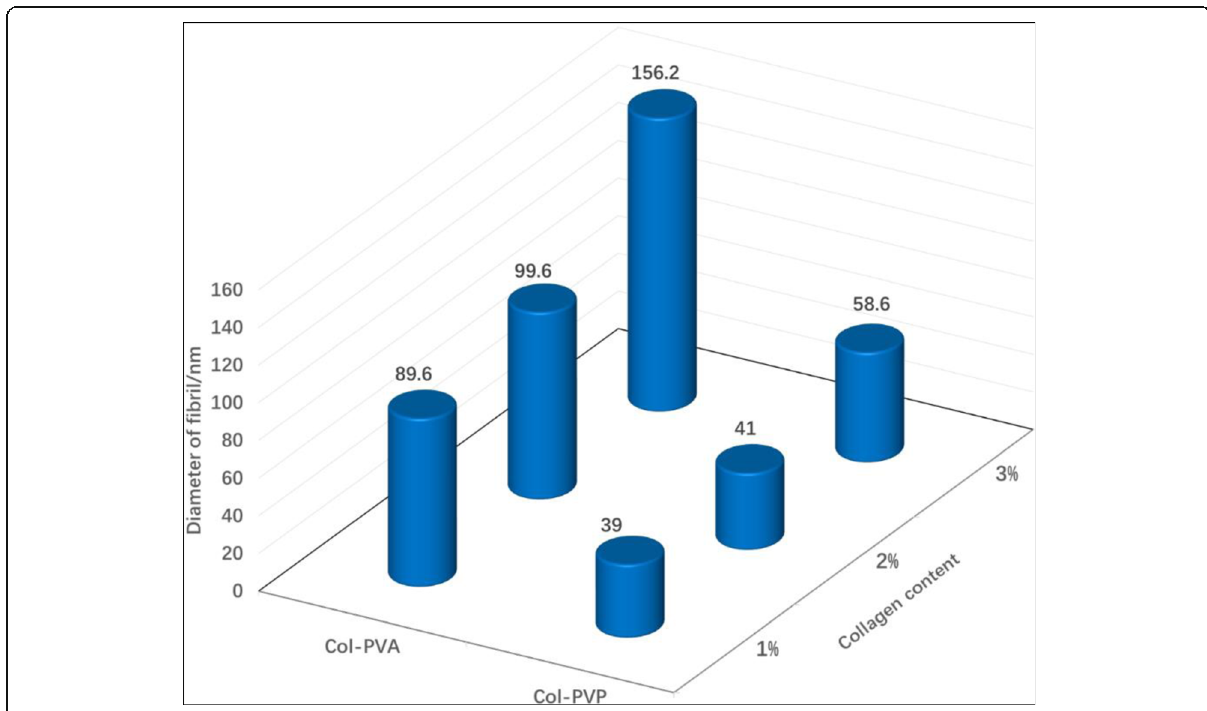
Fig. 7 Diameter of collagen fibrils in PVA (Col-PVA) and PVP (Col-PVP) films containing 1%, 3% and 5% of collagen respectively